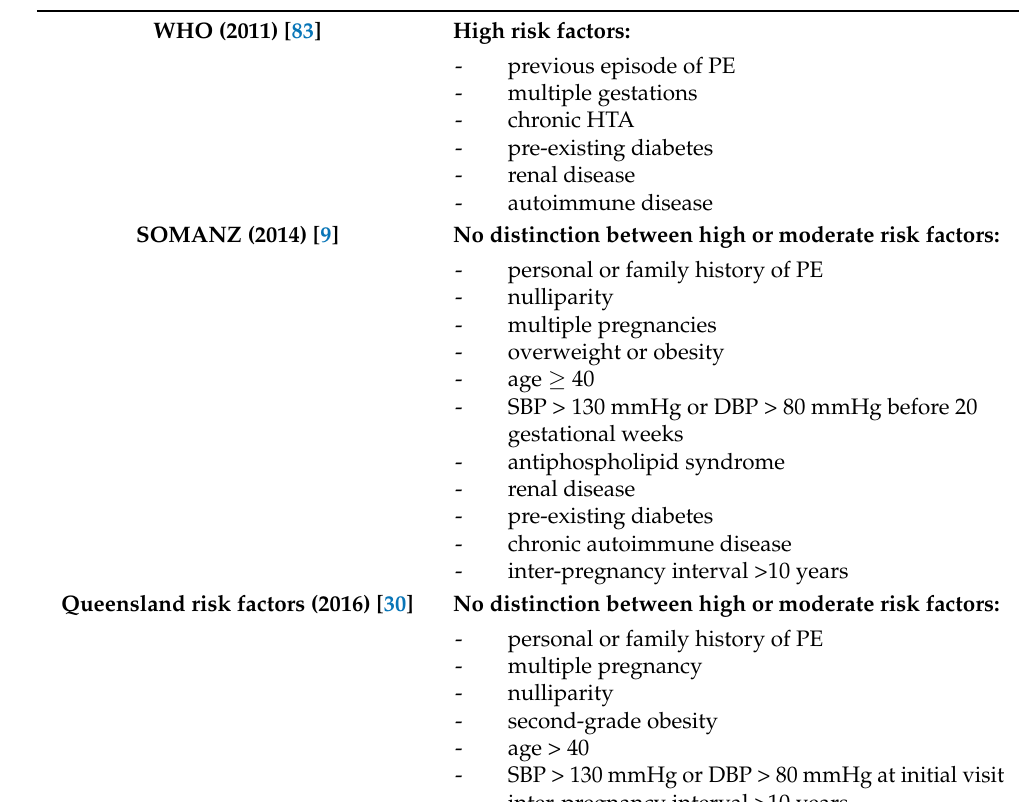
Table 4. PE risk factors, according to international